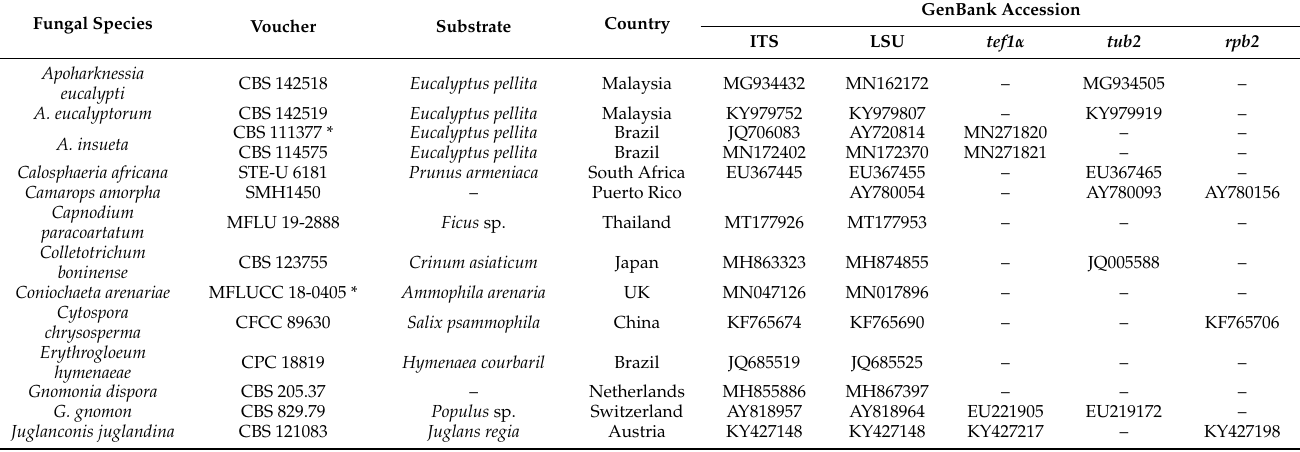
Table 2. Information of specimens used in this